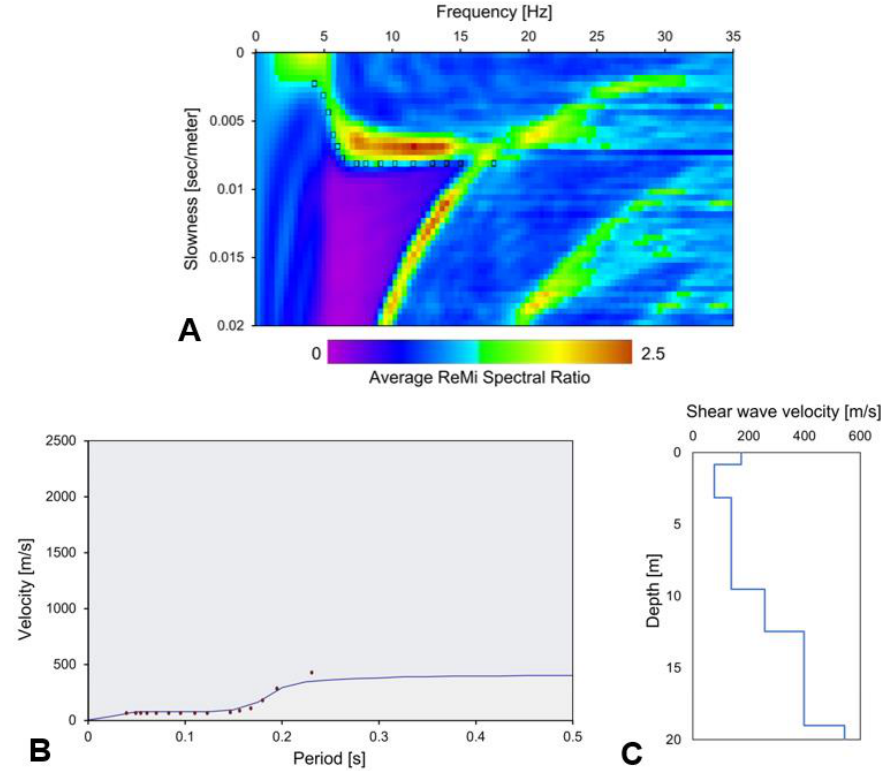
Figure 2. ( A ) Sample of a generated p-f image from the ReMi surveys and the identified dispersion curve and picks (black box) in the ReMi Vspect module. ( B ) Fitting of dispersion curve model into the dispersion picks in the ReMi Disper module. ( C ) Corresponding one-dimensional shear wave velocity profile from the dispersion curve model.